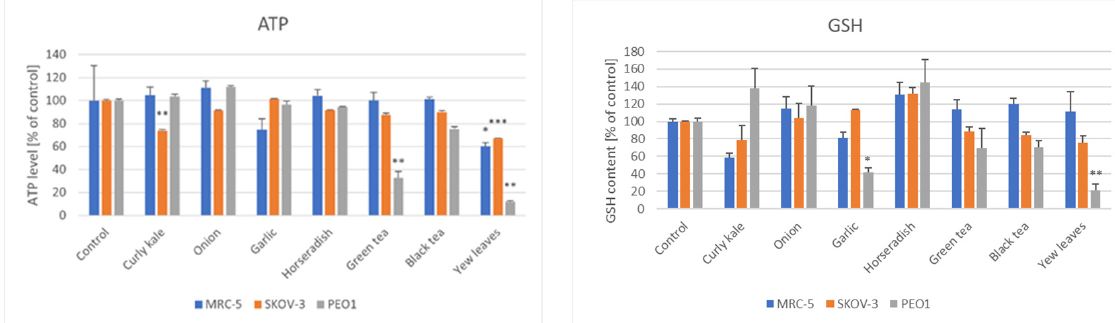
Figure 4. Effect of vegetable extracts, green tea and yew leaves extracts on the ATP level and glutathione (GSH) content of ovary cancer cells and MRC-5 fibroblasts. * p < 0.05, ** p < 0.001, *** p < 0.001 (with respect to Control).